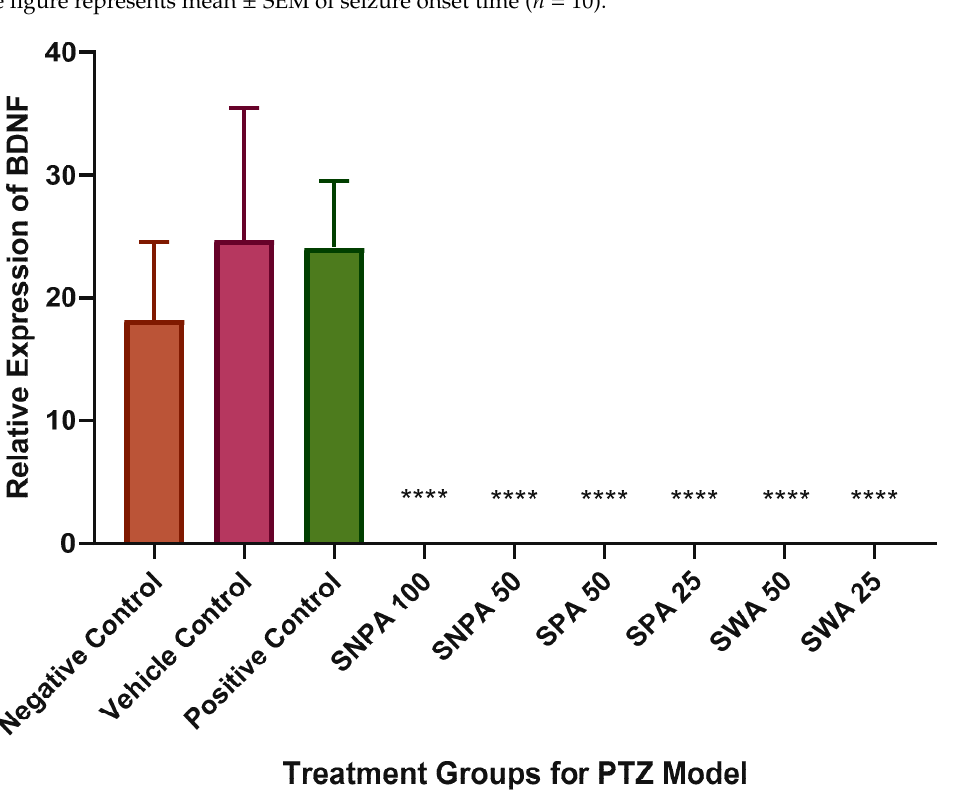
Figure 5. Graphical representation of the relative expression of brain-derived neurotrophic factor (BDNF) in treatment groups ( n = 6). The data were expressed as mean ± SEM by applying one-way ANOVA (**** p < 0.0001).